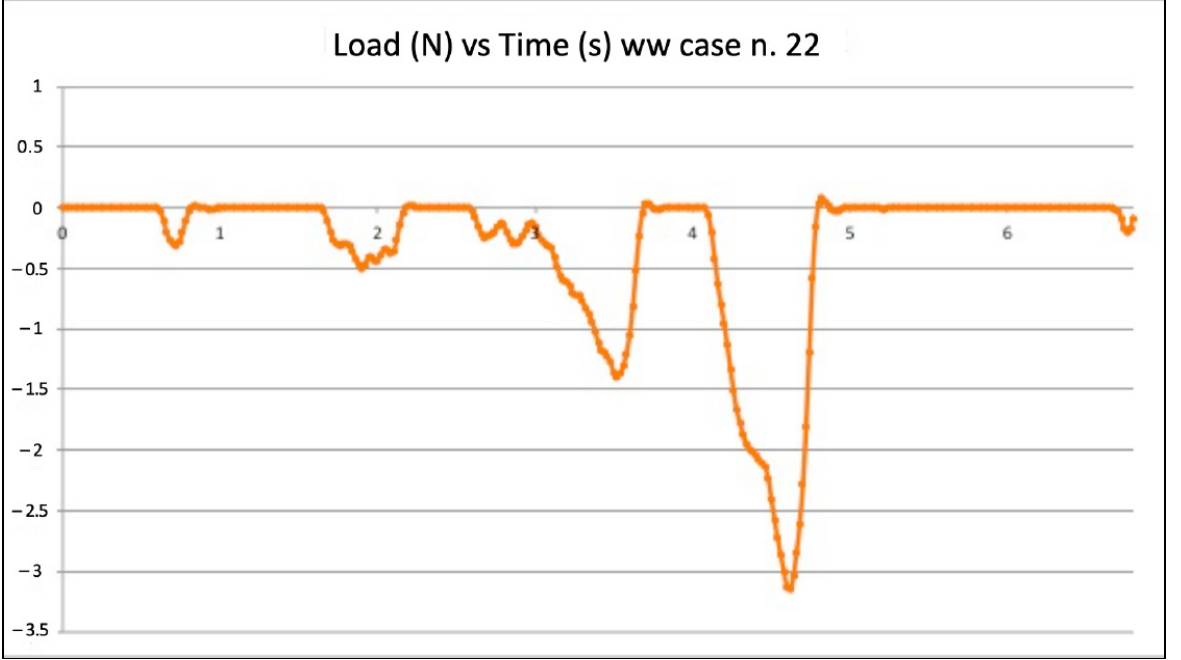
Figure 3. Graphic plot of the simulation on model n. 22 (failed watch winding motion negotiation).